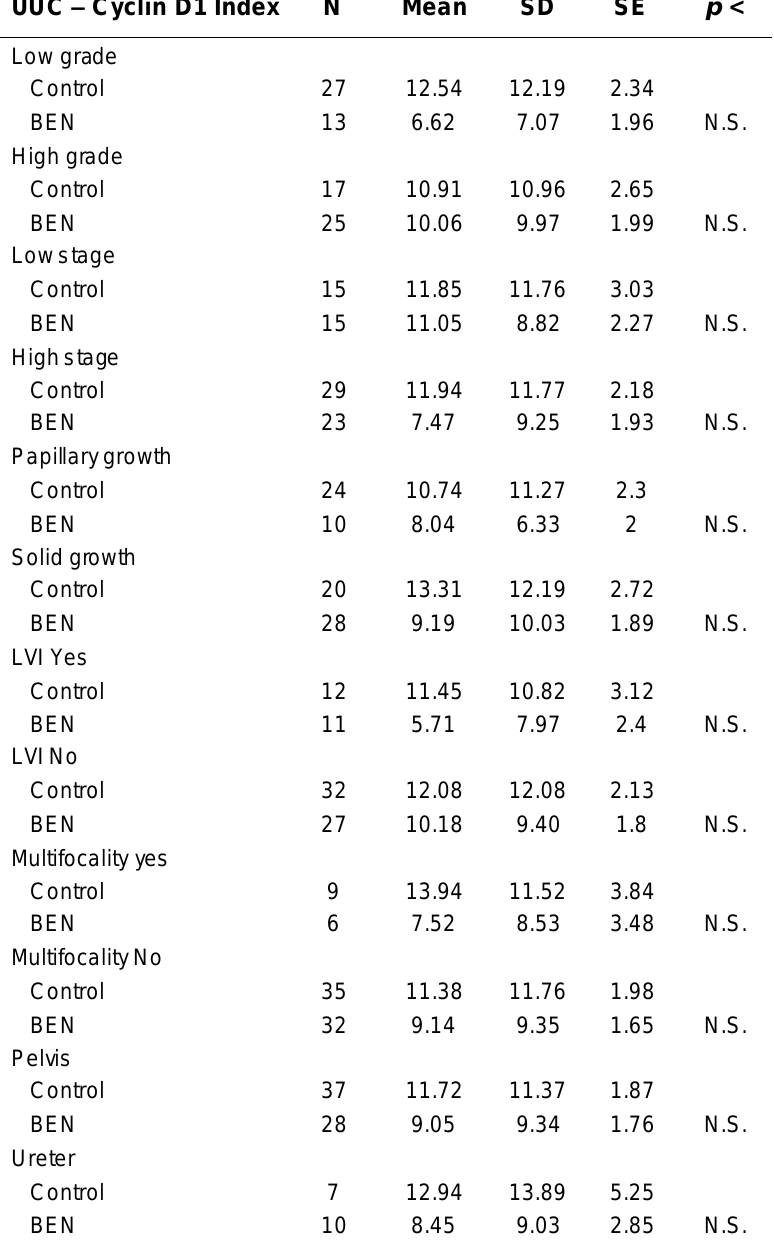
Pathological Variables of UUC and Cyclin D1 Index in Control and BEN